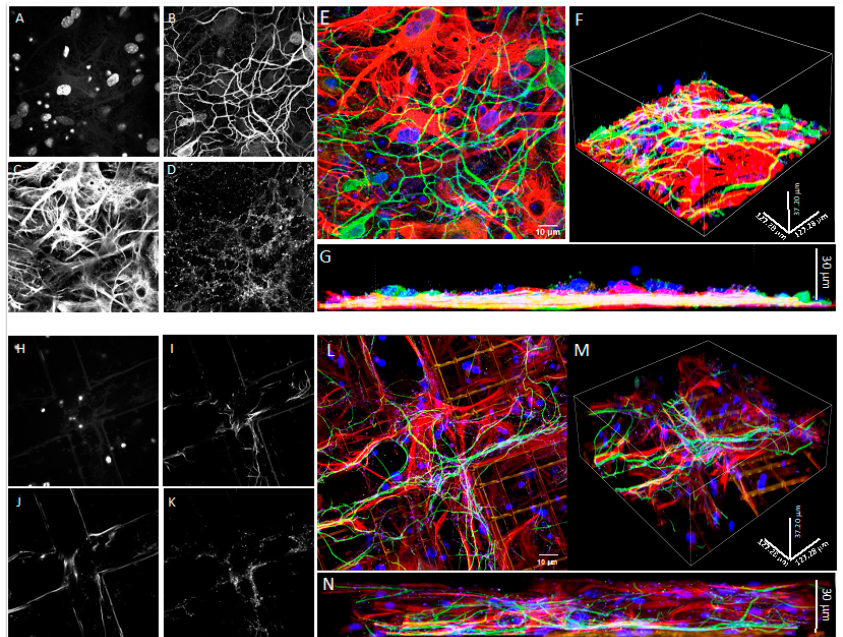
Figure 7. Confocal microscopy of DIV21 hippocampal co-cultures of astrocytes and neurons in 2D and in the 3D synthetic microscaffold Nichoid. ( A – D ) Grayscale images from horizontal sections of 2D hippocampal co-cultures of astrocytes and neurons marked with Hoechst ( A ), MAP2 ( B ), GFAP ( C ), and drebrin ( D ). ( E ) Merged fluorescence image of 2D hippocampal co-cultures with Hoechst in blue, MAP2 in green, GFAP in red, and drebrin in violet. ( F , G ) Lateral views of 2D hippocampal astrocyte and neuron co-cultures displayed in ( E ). ( H – K ) Grayscale horizontal sections of 3D hippocampal astrocyte and neuron co-cultures marked with Hoechst ( H ), MAP2 ( I ), GFAP ( J ), and drebrin ( K ). ( L ) Merged fluorescence image of 3D hippocampal astrocyte and neuron co-cultures with Hoechst in blue, MAP2 in green, GFAP in red, and drebrin in violet. ( M , N ) Lateral sections of 3D hippocampal astrocyte and neuron co-cultures displayed in L. Images were taken with a 100× (oil immersion) objective.